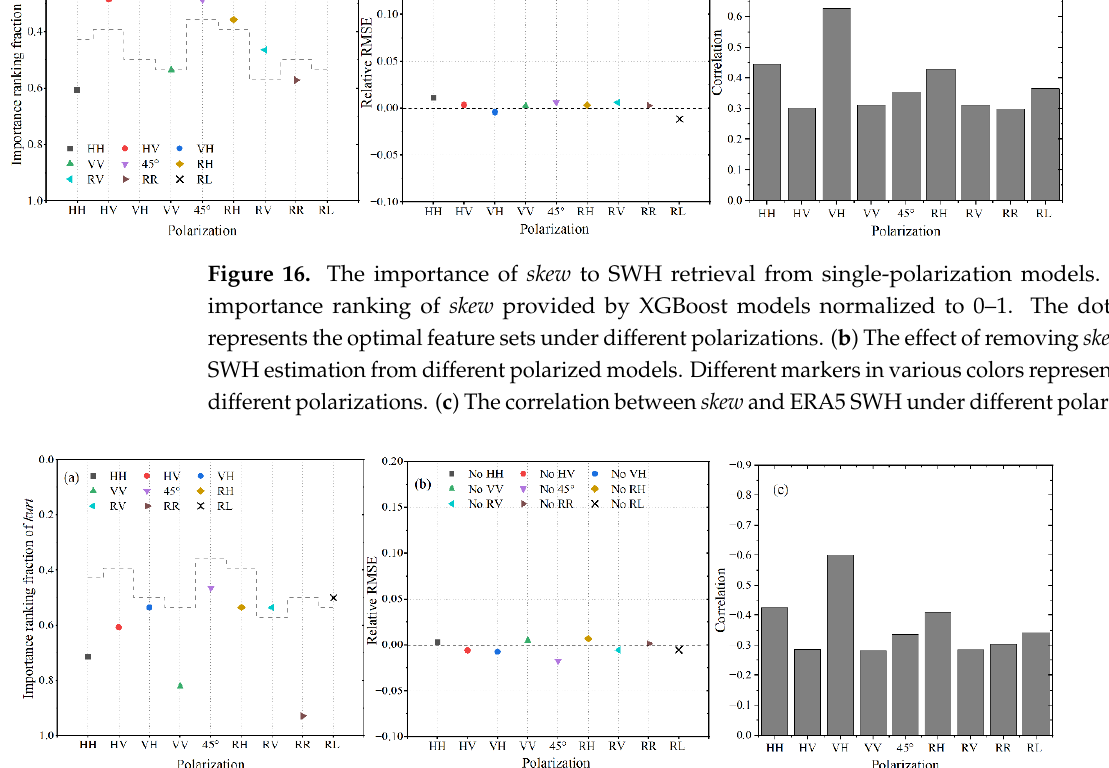
Figure 16. The importance of skew to SWH retrieval from single-polarization models. ( a ) The im- portance ranking of skew provided by XGBoost models normalized to 0 – 1. The dotted line represents the optimal feature sets under different polarizations. ( b ) The effect of removing skew on the SWH estimation from different polarized models. Different markers in various colors represent skew of different polarizations. ( c ) The correlation between skew and ERA5 SWH under different polariza- tions.